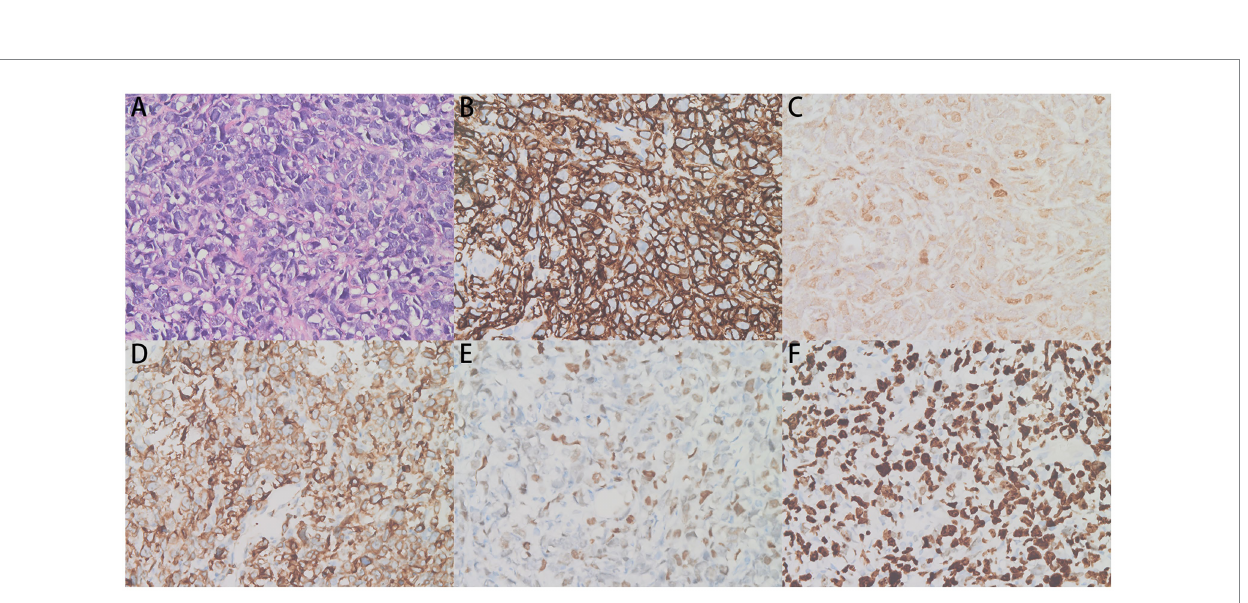
FIGURE 4 Pericardial biopsy showing irregular lymphocyte infiltration. (A) The hematoxylin and eosin (H&E)-stained tissues (×400) and (B–F) CD20 (+), c-Myc (2+, 40%), Bcl-2 (+), Bcl-6 (+), and Ki-67 (+) immunohistochemistry assays (×400) are shown.